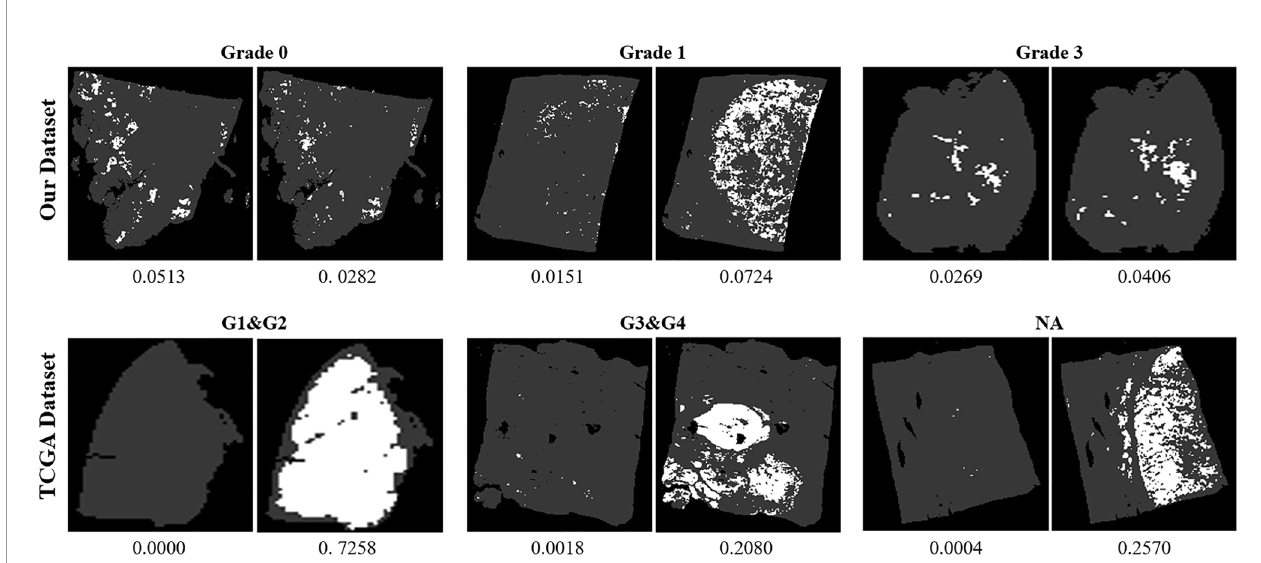
FIGURE 3 | Visualization of slides with different predictions by the baseline and our model. For each slide, the fi gure to the left is the prediction of the baseline model, and the fi gure to the right is the prediction of our model. The ratio below each fi gure denotes the overall ratio of cancerous patches. Except for the slide of grade 0 in our dataset, all the other slides contain tumors with different grades. It can be seen that, although there is not much difference in the predictions of our dataset, the performance of our model is more signi fi cant in the public dataset The Cancer Genome Atlas, which re fl ects the high generalization of our model.